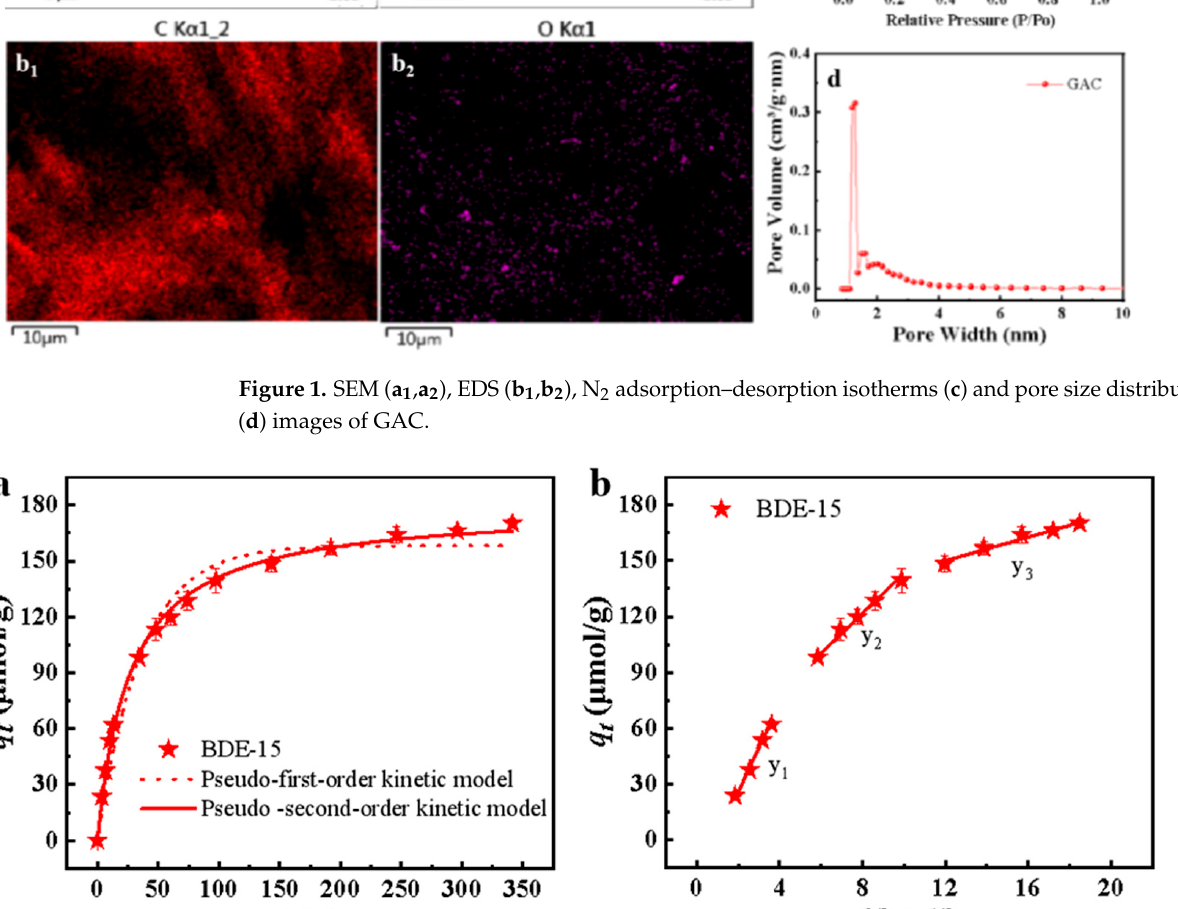
Figure 2. Adsorption kinetics ( a ) and intraparticle diffusion ( b ) for the adsorption of BDE-15 on GAC (Adsorption conditions: T = 298 K; C BDE-15 = 30 µ mol/L; C TX-100 = 1 g/L; pH = 6; Dosage = 0.1